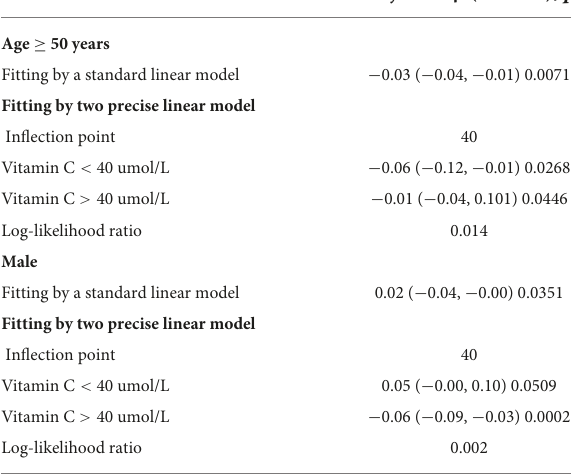
TABLE 5 Threshold effect analysis of vitamin C and DBP using two-precise linear